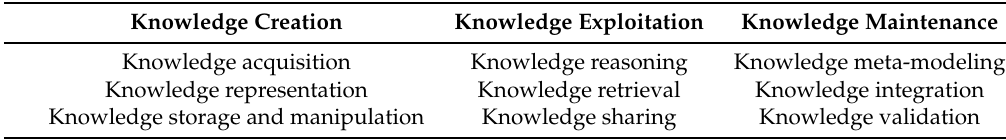
Table 2. Summary of concepts in the Knowledge management